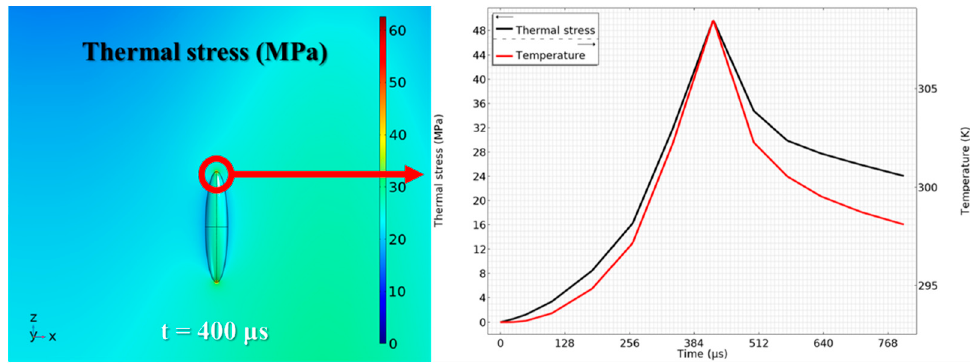
Figure 5. Thermal stress at the endpoint of the long axis of voids.